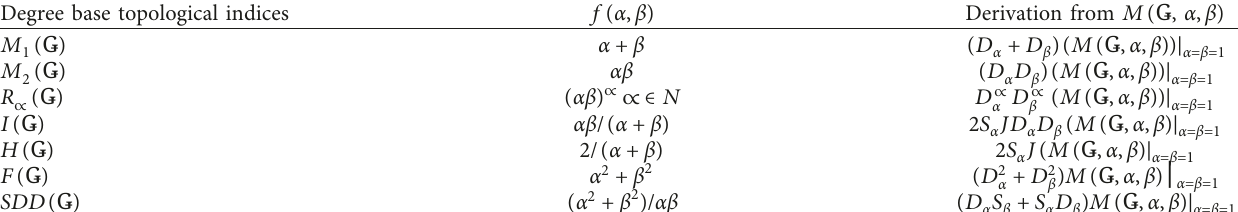
Table 1: Derivation of topological indices from the M polynomial.